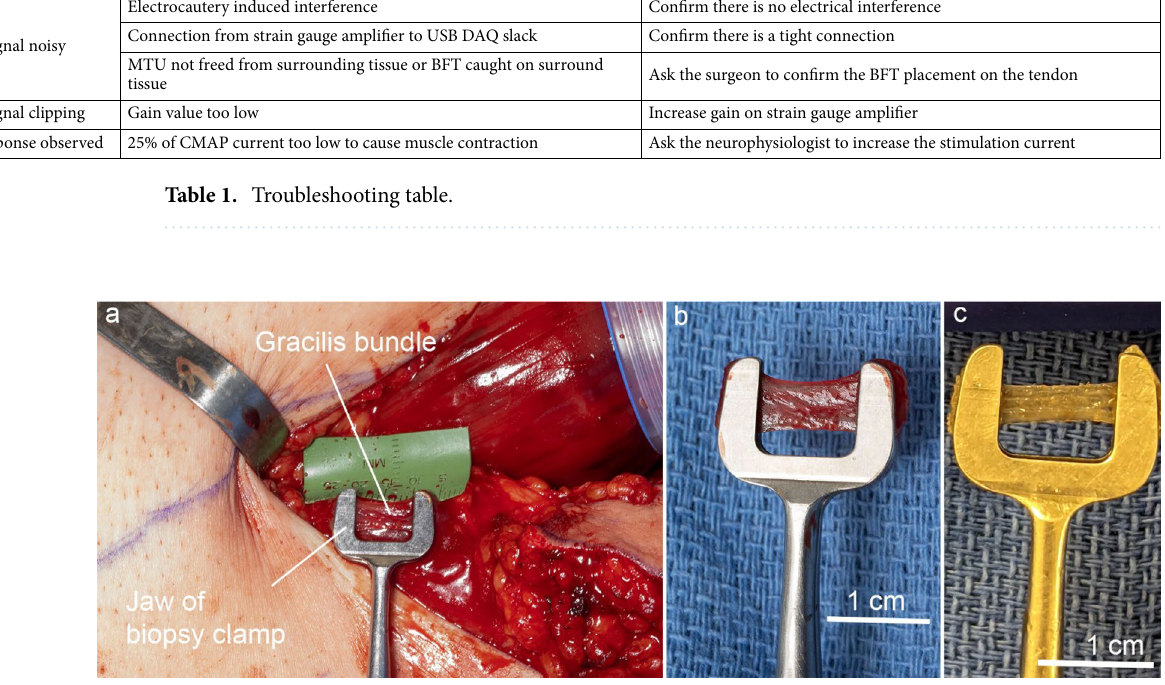
Figure 11. Muscle biopsy. ( a ) The gracilis bundle is positioned within the biopsy clamp and the clamp is engaged. ( b ) Biopsy sample after release from surround tissue and dissection from the gracilis. ( c ) Biopsy